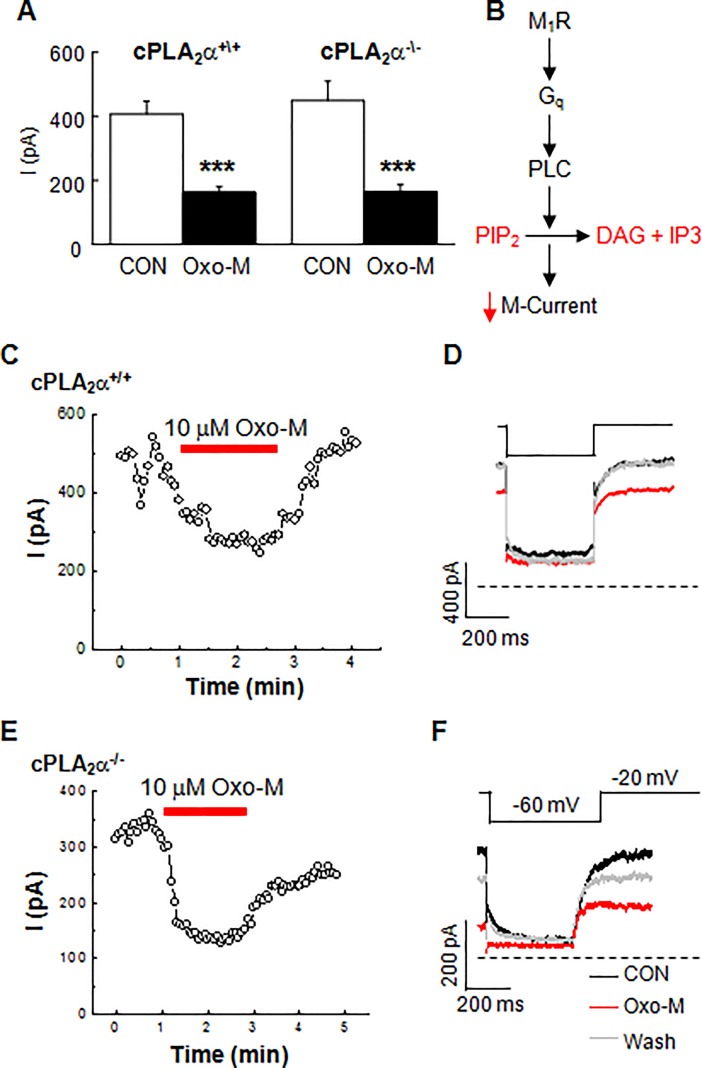
M-current inhibition by Oxo-M remains robust in cPLA2α-\- SCG neurons.(A) Summary bar graph of the average M-current inhibition in cPLA2α+/+ (***p ≤ 4 x10-6; n = 13) and cPLA2α-/- (***p ≤ 6 x 10−5; n = 14) neurons following Oxo-M. (B) Schematic of the signaling cascade inhibiting M-current. Example time courses and selected individual traces from cPLA2α+/+ (C-D) and cPLA2α-/- (E-F) neurons.